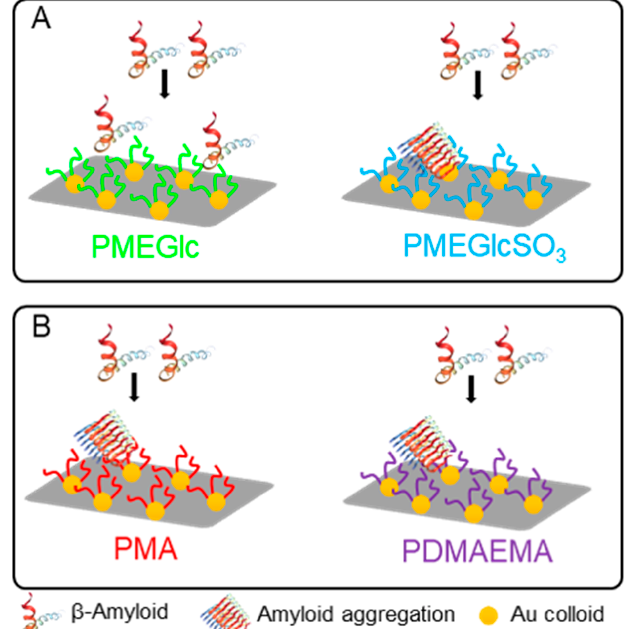
Figure 6. Interaction of β -amyloid with di ff erent polymer brushes. ( A ): influence of the presence of the sulfate group on the glycopolymer; ( B ): non-specific interaction of PMA and PDMAEMA by hydrogen bonding and electrostatic interactions, respectively.